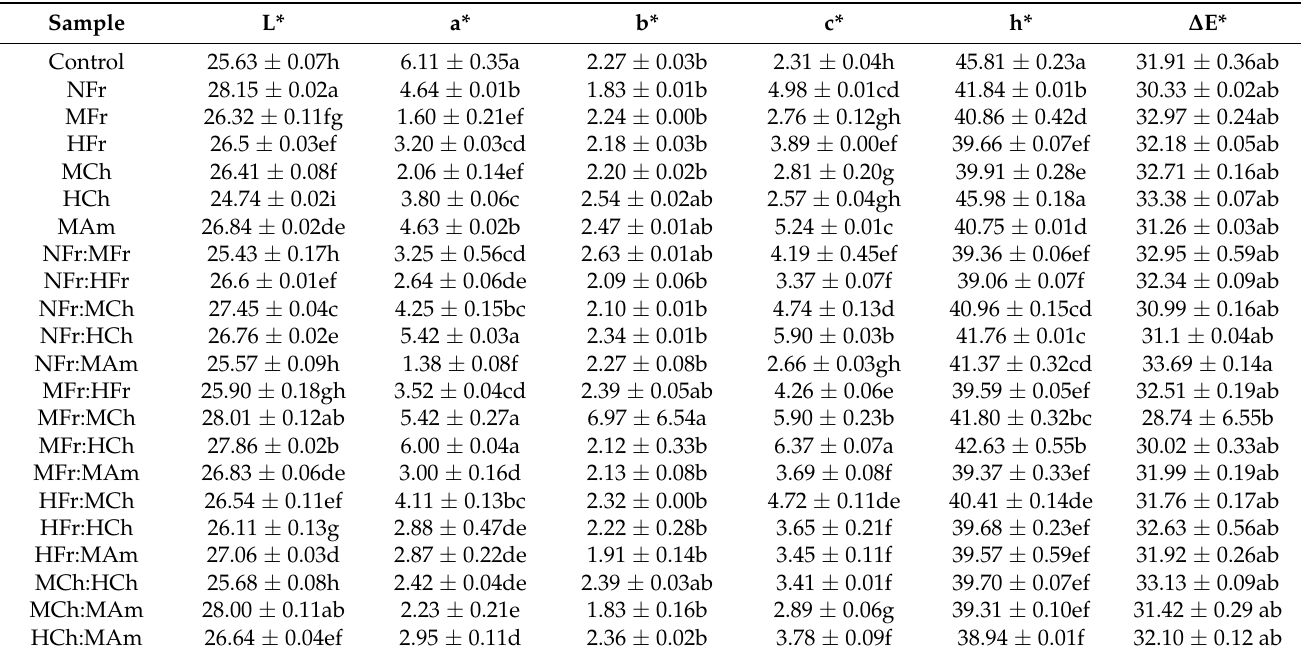
Table 4. Color parameters of wines of Vitis amurensis (n =